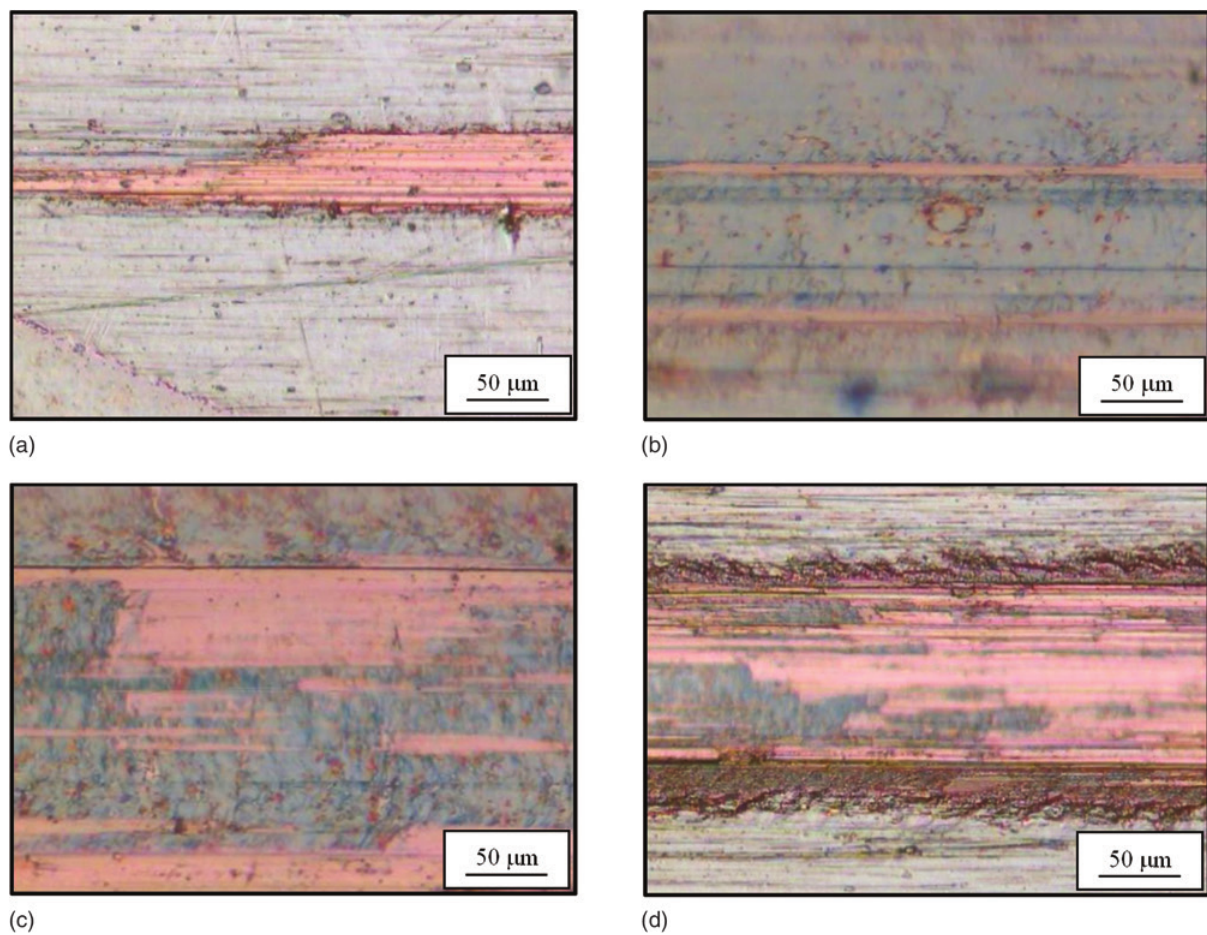
Fig. 6: Scratch track images for SiC x N y (H)/alloy system under load: a) 2 N, b) 5 N, c) 10 N, d) 13 N.